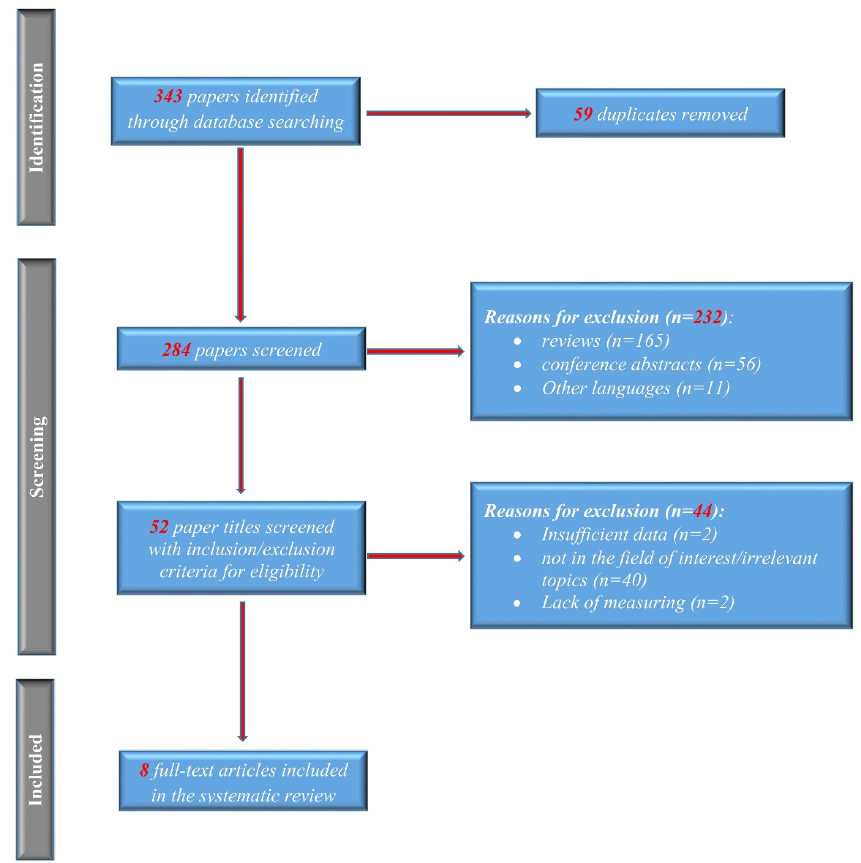
Figure 1. PRISMA flow of the selection process.